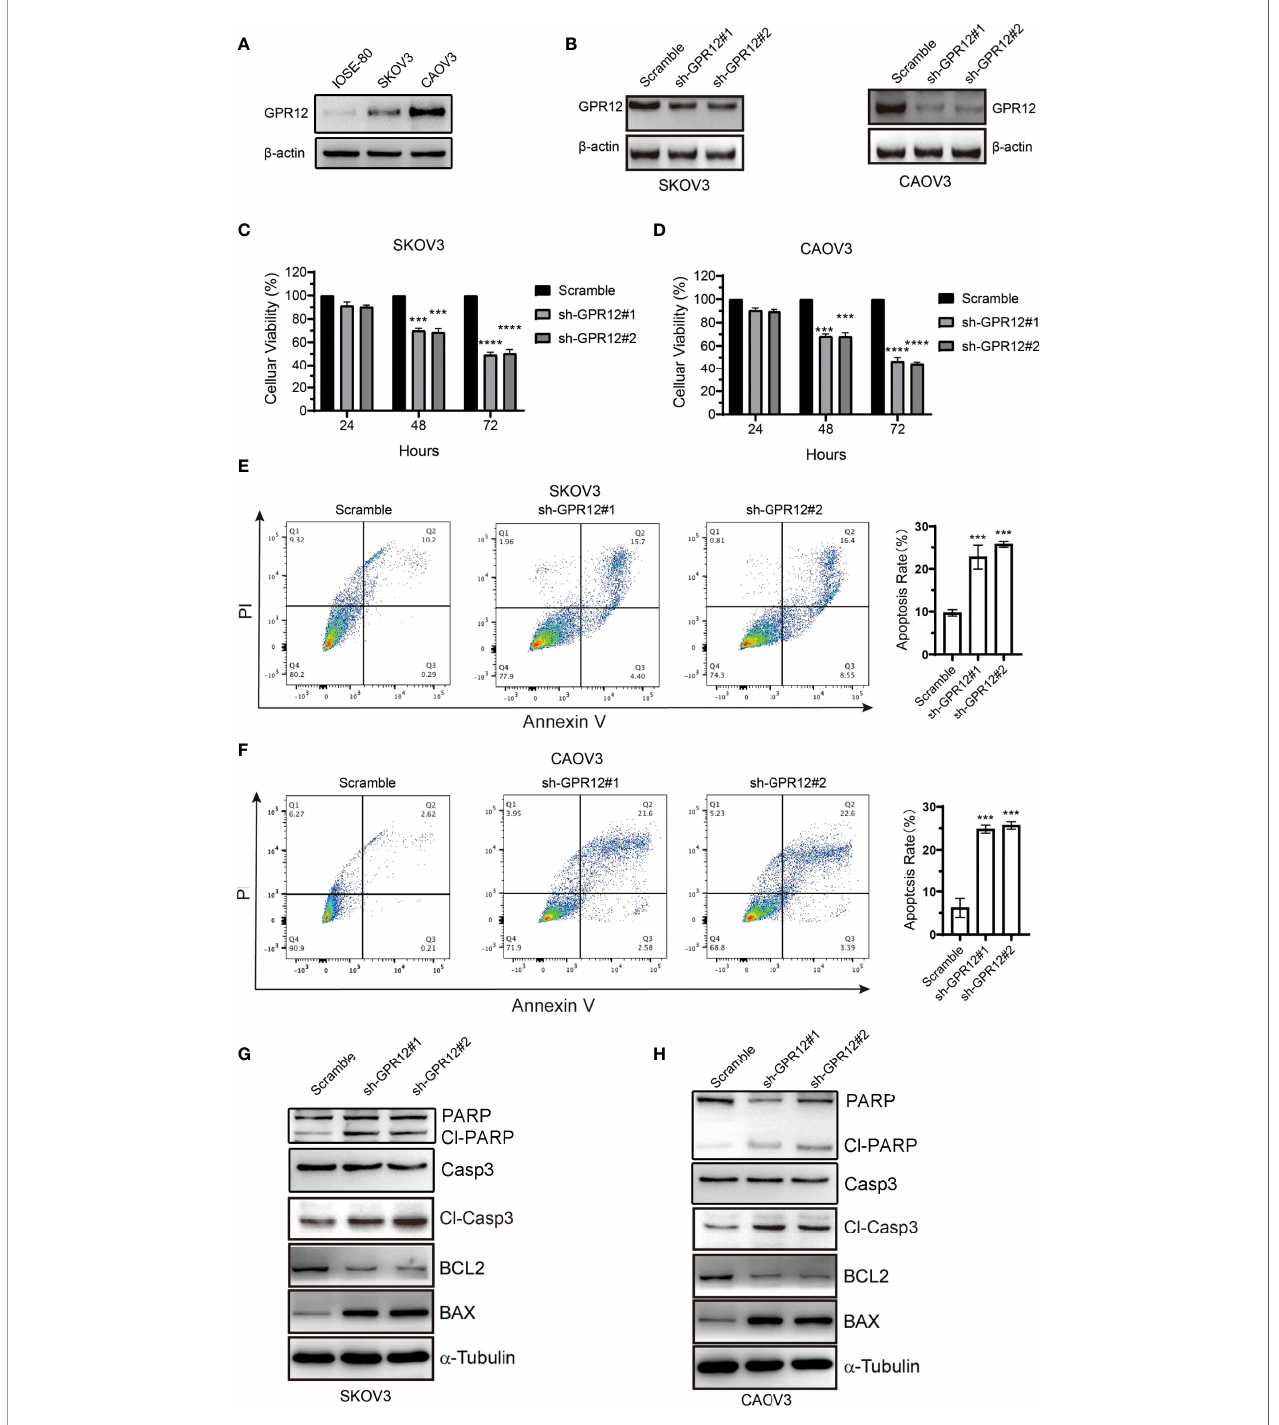
FIGURE 2 | GPR12 knockdown with GPR12-shRNAs inhibits the viability and induces apoptosis of EOC cells. (A) Protein expression of GPR12 in normal ovarian epithelial cell (IOSE-80) and two epithelial ovarian cancer cell lines (SKOV3 and CAOV3) was determined by Western blot. (B) GPR12 expression was knocked down with GPR12-shRNAs in SKOV3 and CAOV3 cells. (C, D) , The cell viabilities of SKOV3 and CAOV3 cells were determined when GPR12 was knocked down at 24, 48, and 72 h, respectively. (E, F) , The cellular apoptosis was analyzed with Flow Cytometry using Annexin V + and PI + staining in SKOV3 and CAOV3 cells transfected with/without GPR12-shRNAs. (G, H) Western Blot method was used to detect the expressions of PARP, capase3, cleaved caspase3, Bcl-2, and BAX in SKOV3 and CAOV3 cells after GPR12